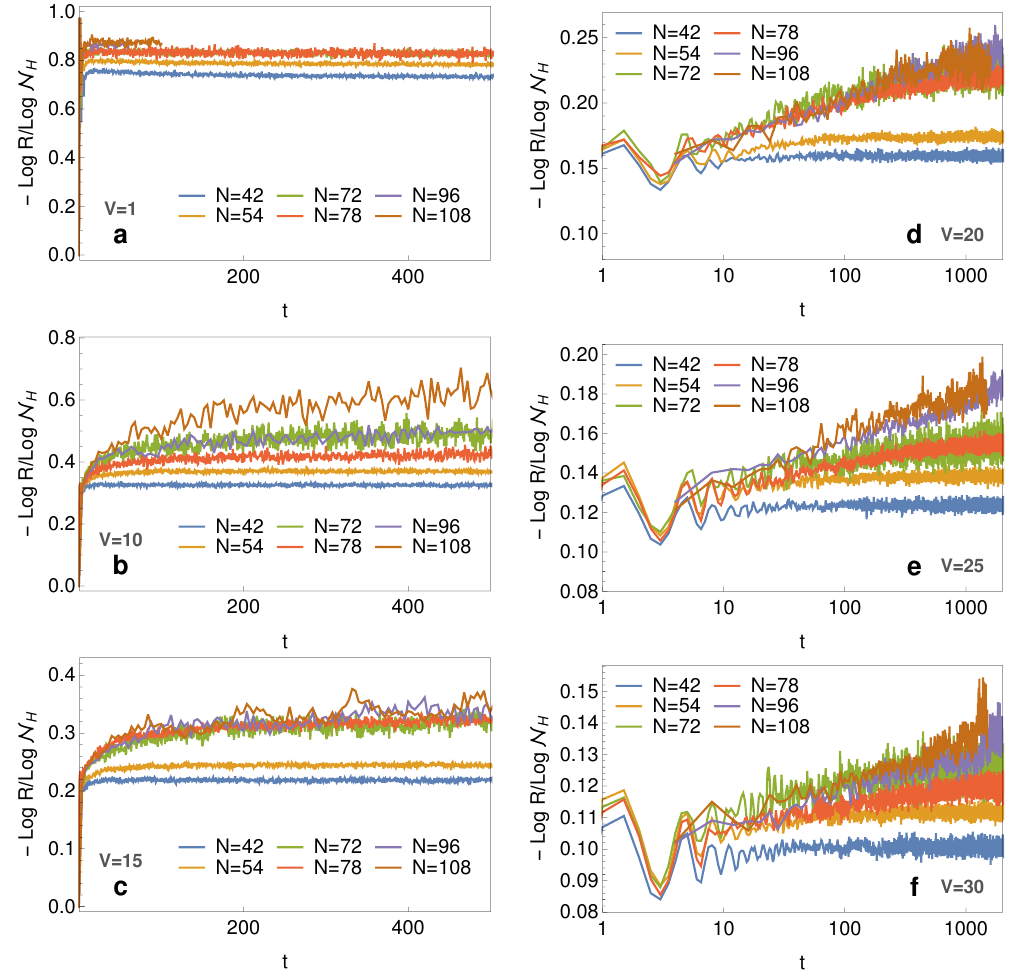
Figure 12: Time dynamics of the return probability of the initial product state, rescaled by the system size − ln R / ln N . Left column. H from top to bottom, V = 1 (panel a ), V = 10 (panel b ) and V = 15 (panel c ). Right column. Values for high disorder, showing a logarithmic increase: from top to bottom, V = 20 (panel d ), V = 25 (panel e ) and V = 30 (panel f